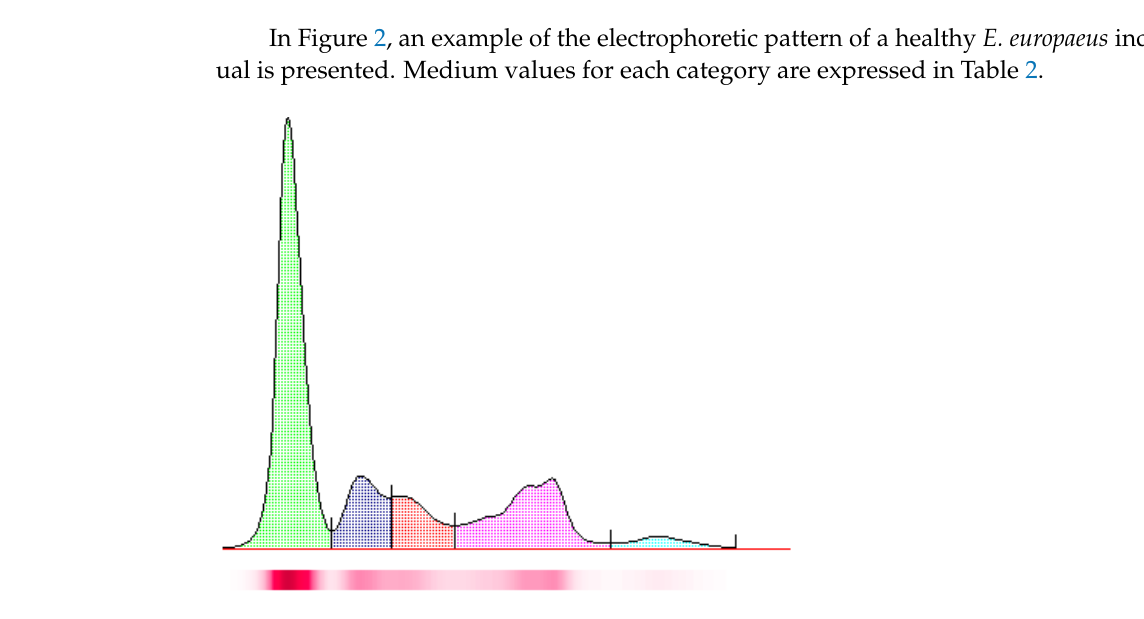
Figure 2. Electrophoretic pattern of a healthy individual of the species Erinaceus europaeus , respec- tively. Green—albumin; for globulins: dark blue— α 1; red— α 2; pink— β ; light blue— γ